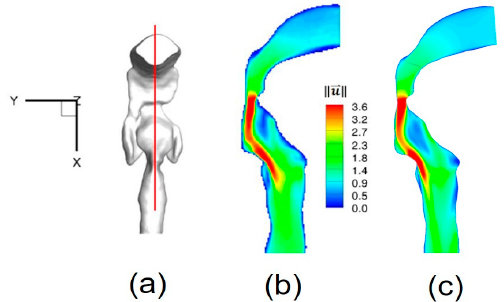
Figure 4. Nondimensionalized velocity magnitude contour comparison at sagittal plane: ( a ) Sagittal plane location; ( b ) Experimental measurement (Reprinted from Reference [11], with permission from Springer); ( c ) Numerical simulation.